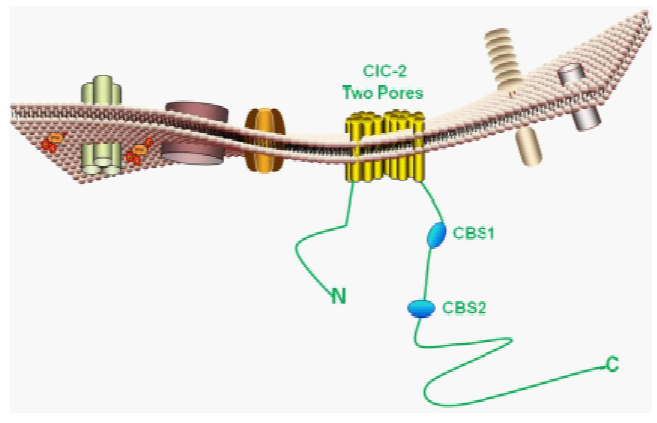
Figure 2. Molecular/structural features of ClC-2 channels. The predicted membrane topology of a ClC-2 monomer is